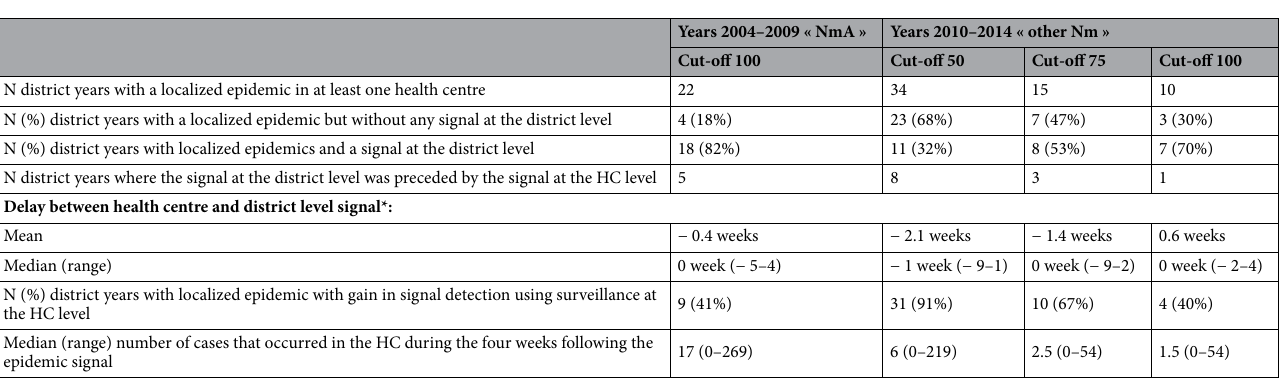
Table 1. Localized meningitis epidemics identified through analysis of surveillance data in health centre level resolution and comparison of the epidemic signals with a surveillance at the district level, by period and by threshold. 14 health centres in Burkina Faso, 2004–2014. Cut-offs are expressed as N weekly cases per 100,000 inhabitants. *negative values mean that the health centre signal preceded the district signal. Positive values usually mean that HC level data were missing for the weeks when the district epidemic was